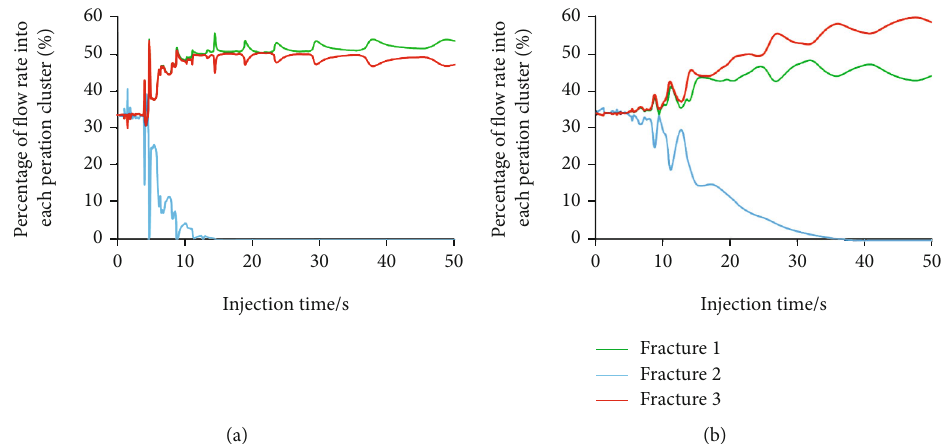
Figure 12: Percentage of fl ow into each cluster as a function of time for di ff erent fracturing fl uid viscosities: (a) case 1 (1 cp); (b) case 3 (100cp).